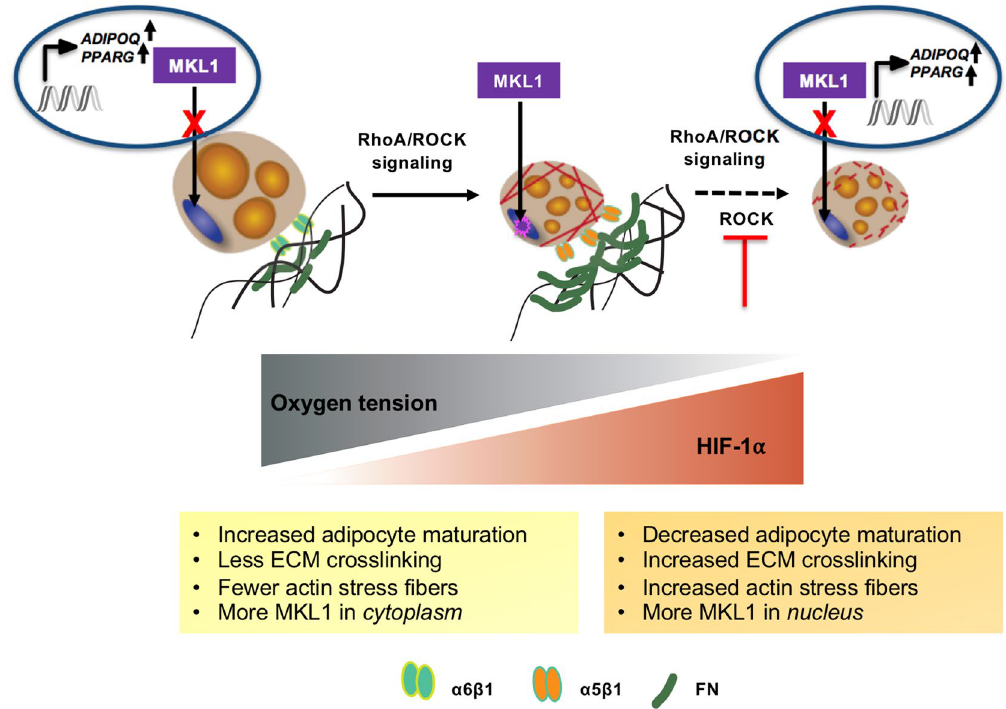
Figure 6. Summary overview. Hypoxia creates a diseased phenotype by (1) inhibiting adipocyte maturation via downregulating adipogenic ( ADIPOQ, PPARG ), and ITGA6 gene expression, and (2) inducing actin stress fiber formation through MKL1 translocation to the nucleus. MKL1 nuclear translocation is regulated via RhoA/ ROCK signaling pathway and inhibiting ROCK attenuates hypoxia